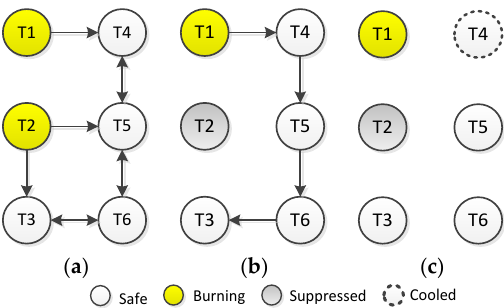
Figure 2. Optimal firefighting strategy for Scenario 1. ( a ) T1 and T2 are on fire. ( b ) T1 is on fire while T2 is suppressed. ( c ) T1 is on fire, T2 is suppressed, and T4 is cooled.